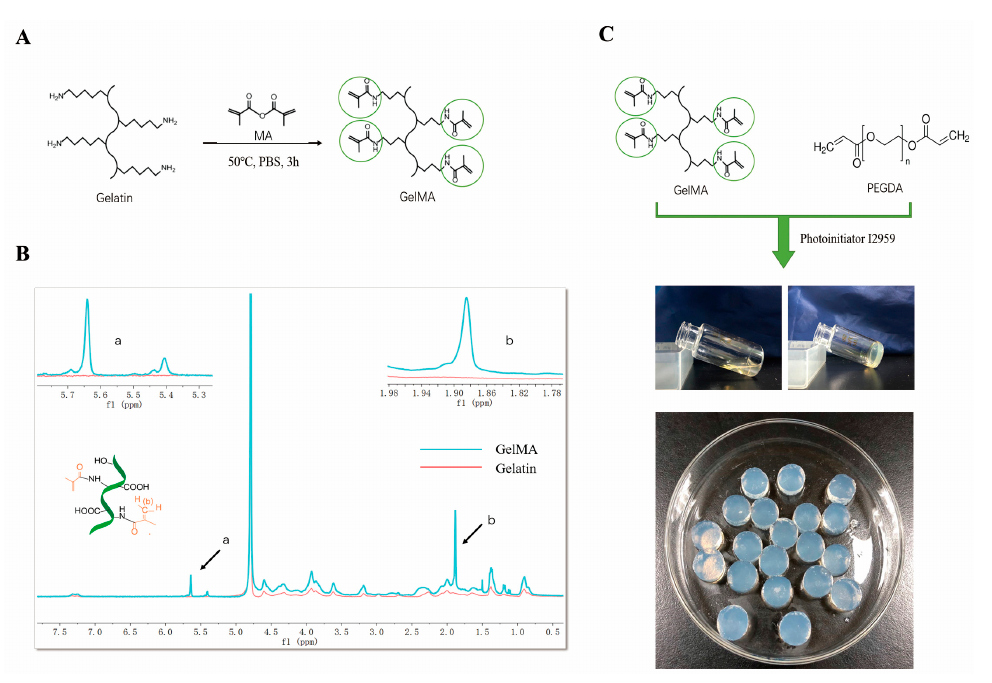
Figure 1. ( A ) Synthesis mechanism of GelMA; ( B ) the 1 HNMR spectra of the GelMA (a, δ = 5.4 and 5.6 ppm; b, δ = 1.87 ppm); peaks at 5.4 ppm and 5.6 ppm correspond to two H methacrylic double bonds, while the peak at 1.87 ppm corresponds to the methyl group of methacrylic acid; ( C ) GelMA/PEGDA solution before and after 5 min UV treatment.